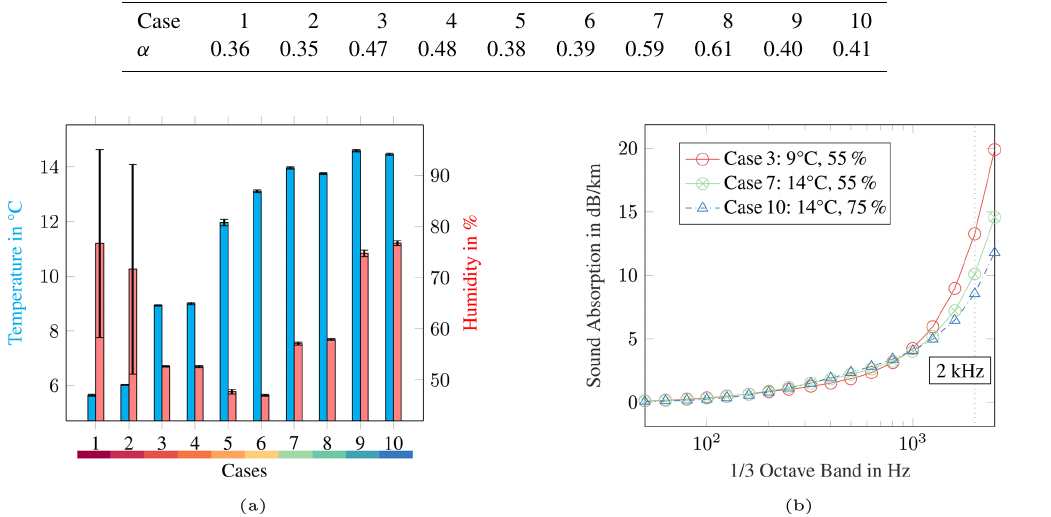
Figure 5. Parameters describing the atmospheric air absorption for the validation cases. (a) Measured values and standard deviation of 10min data for temperature and relative humidity at 53m. (b) Calculated sound absorption for selected cases having similar values of temperature and relative